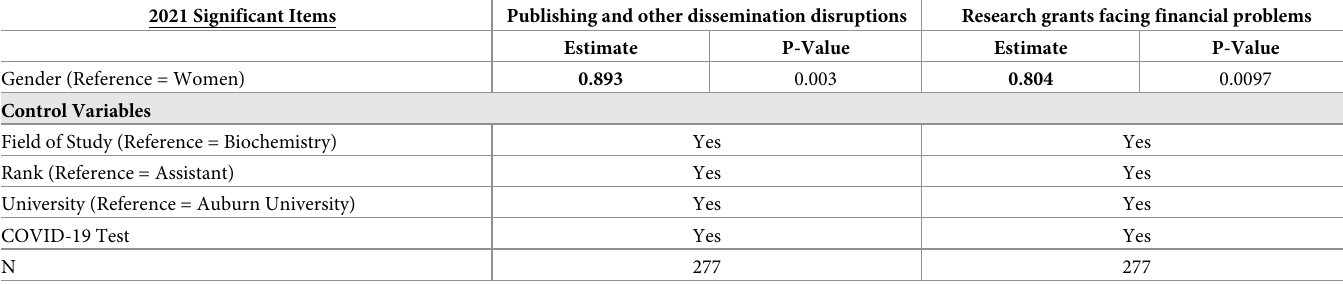
Table 5. Logistic model estimating gender differences in 2021 controlling for field of study, rank, and if the respondent tested for COVID-19.